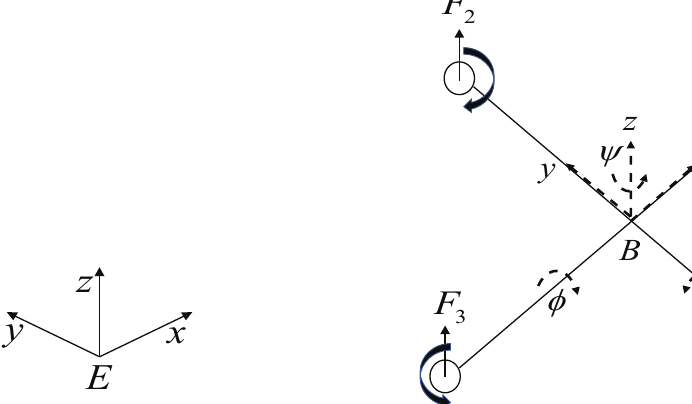
Figure 1. Coordinates of a quadrotor UAV.